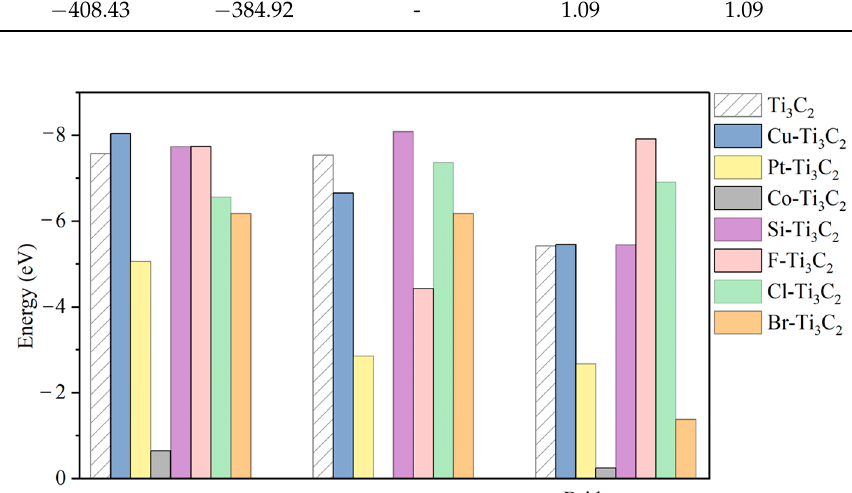
Figure 4. Comparison of the formaldehyde adsorption energy of various doping systems. As it can be seen from Table 2, among all metal cations (Cu, Pt, Co), copper doping had the best modification effect on Ti 3 C 2 , improving the adsorption effect of the Ti 3 C 2 substrate on formaldehyde at the top and bridge sites, and the adsorption energy in- creased by 0.46 eV and 0.03 eV, respectively. In the hollow position, it decreased by 0.8802 eV. Among the nonmetallic anions (F, Cl, Br), fluorine doping had the best modi- fication effect on Ti 3 C 2 and improved the adsorption capacity of the Ti 3 C 2 substrate to formaldehyde at the top and bridge sites by 0.17 eV and 2.50 eV, respectively, and de- creased by 3.11 eV at the hollow site. Among all the doped elements, only silicon doping significantly increased the adsorption energy of formaldehyde at the three adsorption sites on Ti 3 C 2 substrate and the adsorption energy at the top. Hollow and bridge sites increased by 0.17 eV, 0.55 eV and 0.03 eV, respectively. In addition, only chlorine-doped Ti 3 C 2 improved by 1.50 eV at the bridge site, while Ti 3 C 2 doped with other elements had poor effects at all adsorption sites. Based on the judgment of adsorption energy, it can be known that Cu, Si and F have better modification effect on Ti 3 C 2 substrate. Further re- search can be carried out by doping Ti 3 C 2 with these three elements. When formaldehyde adsorbed stably on the top position of the Cu-doped Ti 3 C 2 surface, the two H–C bond lengths increased by 0.01 Å and 0.02 Å, respectively, and the C–O bond lengths increased by 0.01 Å. When formaldehyde adsorbed stably on the bridge site of Cu-doped Ti 3 C 2 , formaldehyde decomposed into oxygen atoms and meth- ylene group (–CH2). When formaldehyde adsorbed at the hollow position on Cu-doped Ti 3 C 2 , the H–C bond length was shortened by 0.12 Å and 0.14 Å, respectively, and the C– O bond length was basically unchanged. When formaldehyde was stably adsorbed on the surface of F-doped Ti 3 C 2 , it decomposed into oxygen atoms and methylene group (– CH 2 ) at two positions (top and bridge) where the adsorption energy increased. At the hollow site, the H–C bond lengths of formaldehyde were shortened by 0.32 Å and 0.31 Å, respectively, and the C–O bond lengths increased by 0.45 Å. When formaldehyde was stably adsorbed on the top position of the Si-doped Ti 3 C 2 surface, one H–C bond was shortened by 0.03 Å, and the other H–C bond increased by 0.02 Å, and the C–O bond length was basically unchanged. When formaldehyde was stably adsorbed at hollow sites on the Si-doped Ti 3 C 2 surface, the H–C bond lengths increased by 0.01 Å and 0.02 Å, respectively, and the C–O bond length length was basically unchanged. When formal- dehyde adsorbed stably on the bridge site of Si-doped Ti 3 C 2 , formaldehyde was catalyzed to decompose into methylene (–CH 2 ). In order to study the adsorption mechanism of metal atom doping and non-metal atom doping on formaldehyde, the density of states and differential charges of the metal cation Cu atom, non-metal anion F atom and non-metal cation Si atom doping system were calculated.